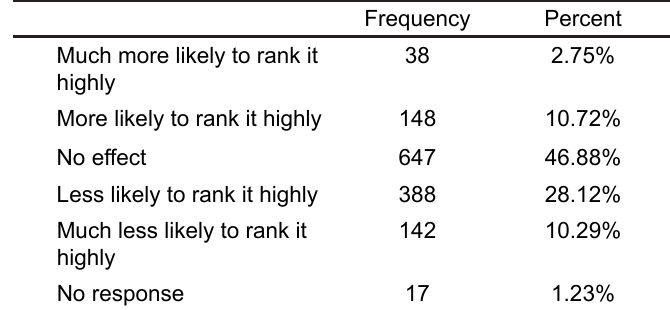
N , total number of responses Table 2. Applicant comfort level of sharing information.